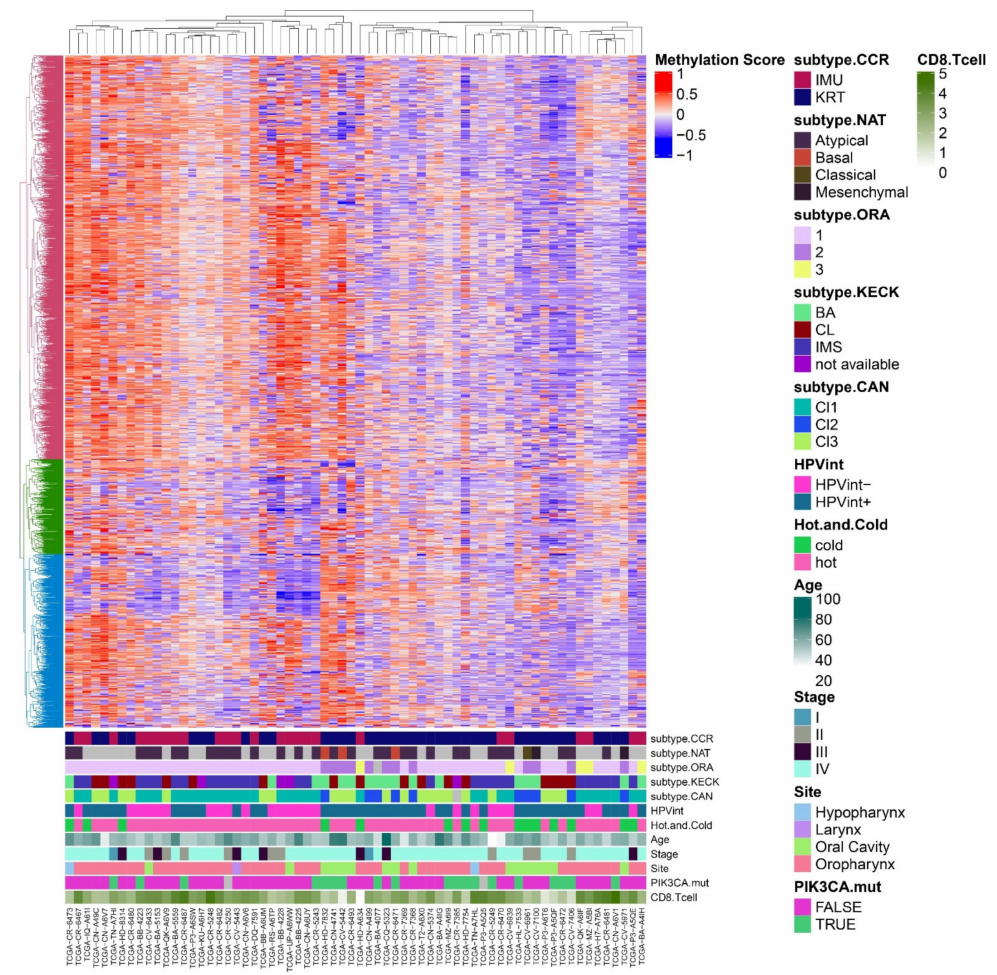
Figure 2. DNA methylation profiles associate with HPV(+) HNSCC subtype. Heatmap of DNA methylation data (nor- malized beta values) assessed by the Illumina 450K BeadChip for 66 HPV(+) HNSC TCGA samples, and annotated with subtypes and additional tumor characteristics. The top 1% most variable CpGs (probes) were used based on standard deviation. The distance matrix was calculated using Euclidean distance, and hierarchical clustering was performed using complete linkage. Cluster colors on left were determined by applying consensus clustering and selecting the optimal number of